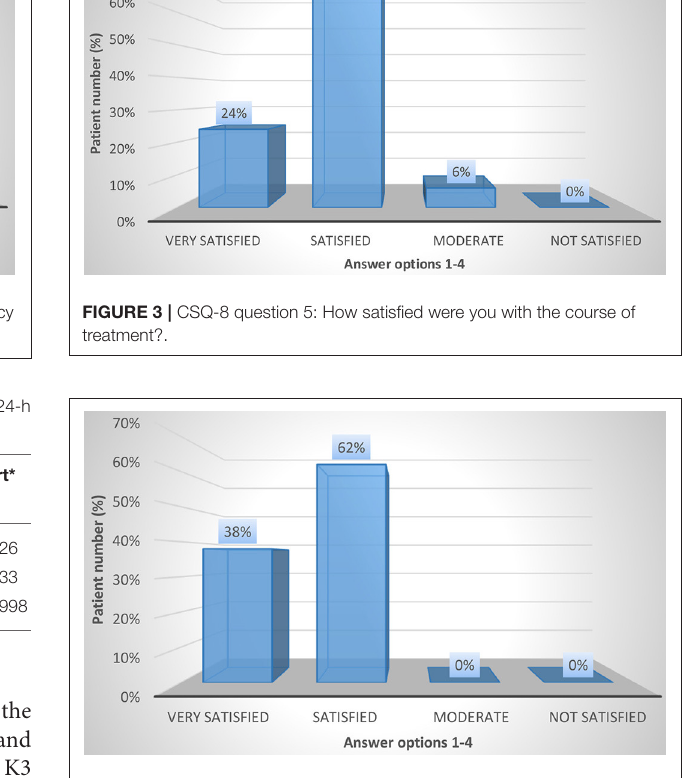
FIGURE 4 | CSQ-8 question 6: How satisfied were you with the overall therapy and the result of the therapy?.